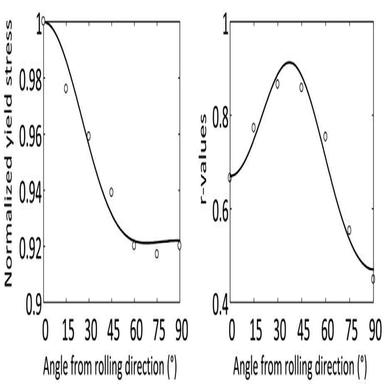
True stress-strain curves in tension along the RD after prestraining in compression to (a) 2% and (b) 4% together with the stress-strain curve for monotonic tension. All curves are plotted up to necking.